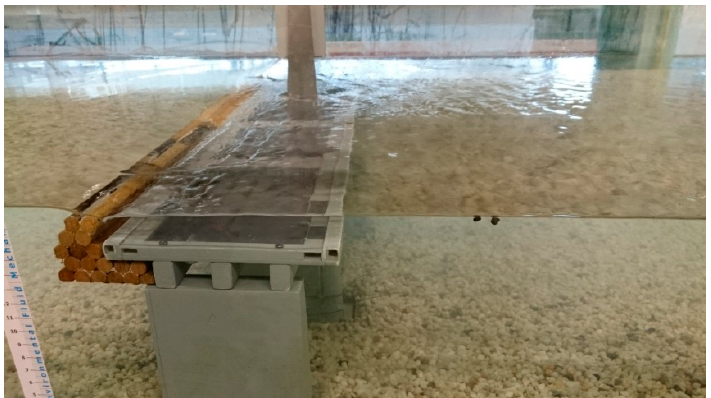
Figure 4. Laboratory setup, including debris damming on the upstream face of decks. The far deck is outfitted with the load cell, while the other two decks are free standing.